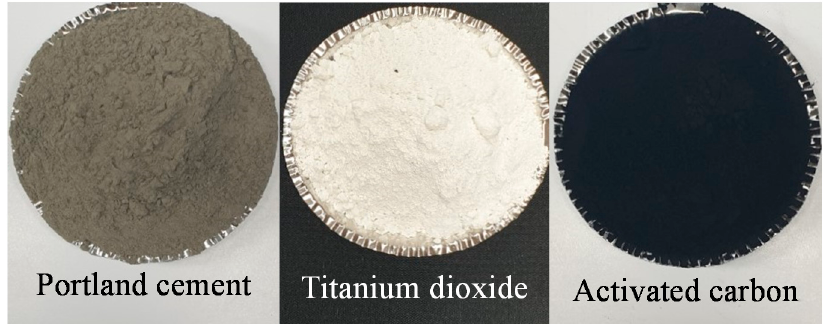
Figure 1. Materials used for the test specimens.